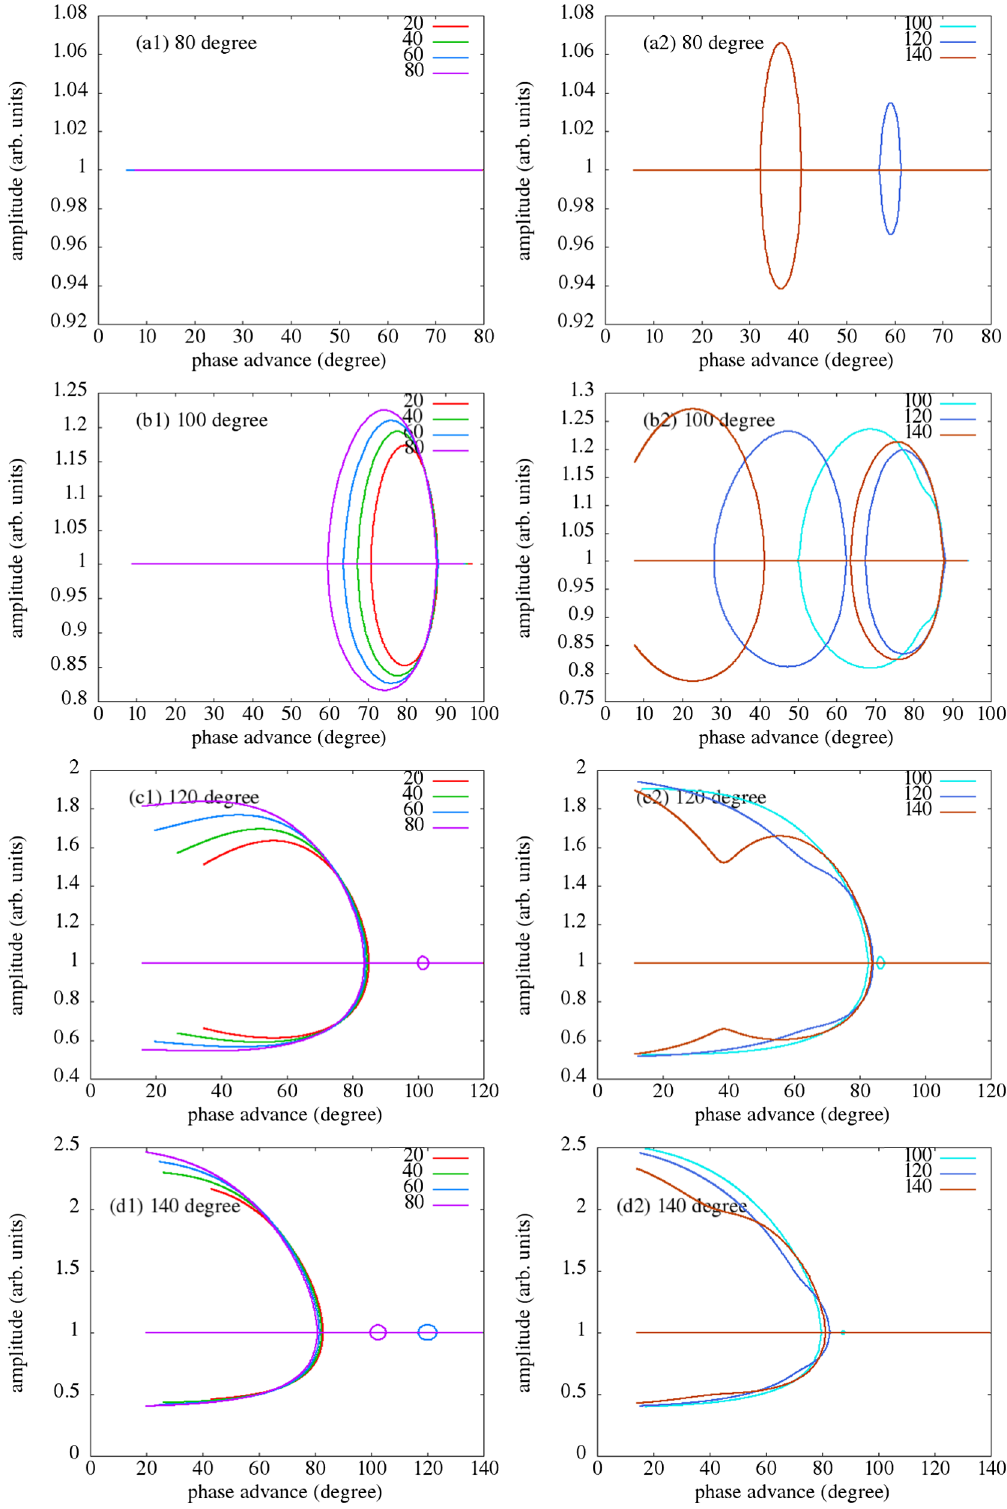
FIG. 8. The 3D envelope mode growth rate amplitudes as a function of depressed transverse phase advance with 20 °, 40 °, 60 °, 80 °, 100 °, 120 °, and 140 ° zero current longitudinal phase advances for (a) 80 °, (b) 100 °, (c) 120 °, and (d) 140 ° zero current transverse phase advances in a periodic quadrupole-rf